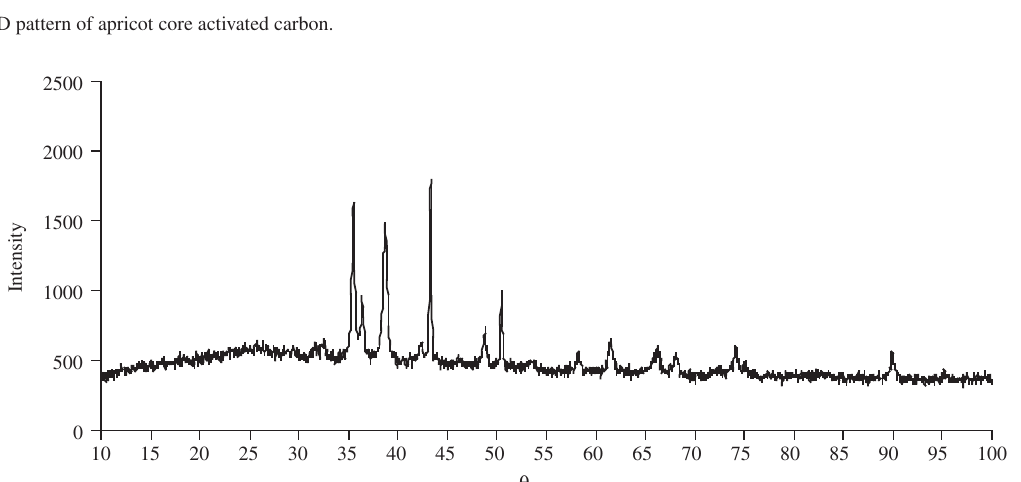
Figure 8. XRD pattern of stalk grape activated